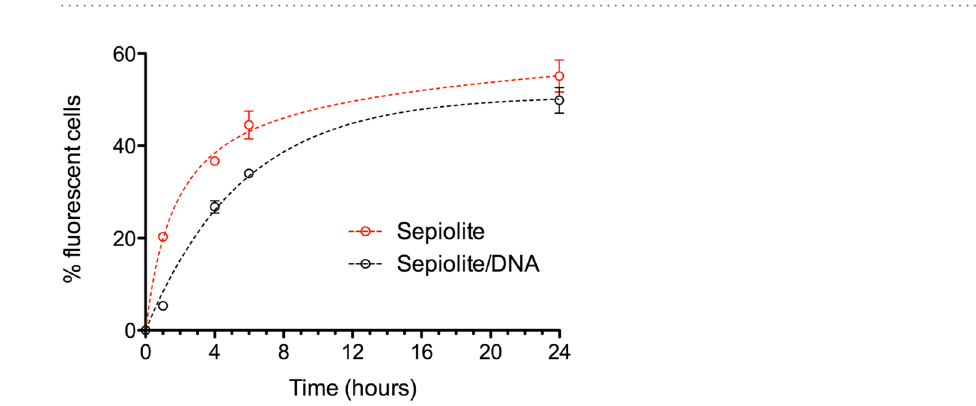
Figure 4. TEM images of the internalization of sepiolite fibers into V79 cells (10 ng· μ L − 1 sepiolite with 5x10 6 cells). ( A ) A complete image of a cell after 0.5 hour of incubation. ( B and C ) A magnified view of a sepiolite fiber in the cell cytoplasm from image A. White arrow shows sepiolite fibers embedded into membranes. ( D ) An image showing endocytosis with membrane invagination (white arrow) and direct fiber insertion (yellow arrow) after 6 h of incubation. E and F : Images showing the macropinocytosis mechanism for sepiolite uptake in V79 cells.